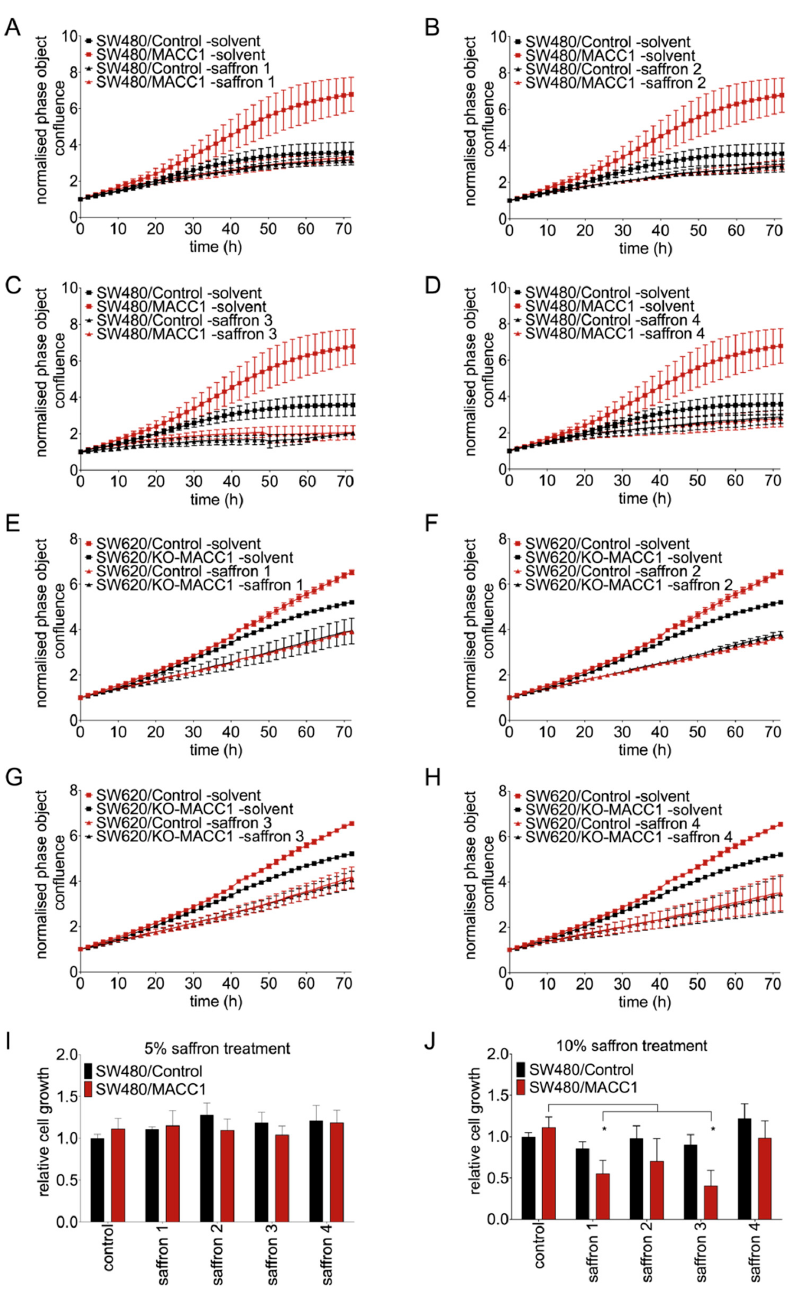
Figure 1. Saffron crudes reduced the proliferation and viability of CRC cells in a MACC1-dependent manner. CRC cells were treated with four different saffron crudes. Every second hour the confluence of the cells was measured by a live cell imaging system. Each saffron crude reduced the proliferation of both SW480/MACC1 ( A – D ) and SW620/Control cells ( E – H ). Cell viability was further assessed using MTT assay, and correlatively to the previous results, each saffron crude decreased the cell viability in a concentration-dependent manner. Cells treated with 5% saffron did not show a reduced viability ( I ) whereas the 2-fold increased amount of saffron reduced the cell viability most pronounced for saffron 1, 2 and 3 ( J ). Data are represented as mean ± SEM ( n ≥ 3). p values were calculated using one-way ANOVA, * p < 0.05.